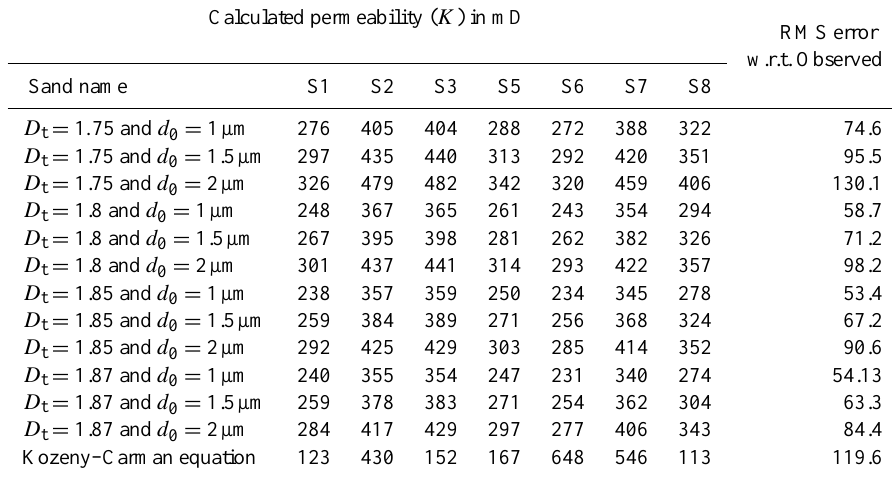
Table 4. Average values of reservoir permeability in each layer estimated for different values of D t and d 0 and from the Kozeny–Carman equation. For each estimated set the RMS error with respect to observed average reservoir permeability is given.